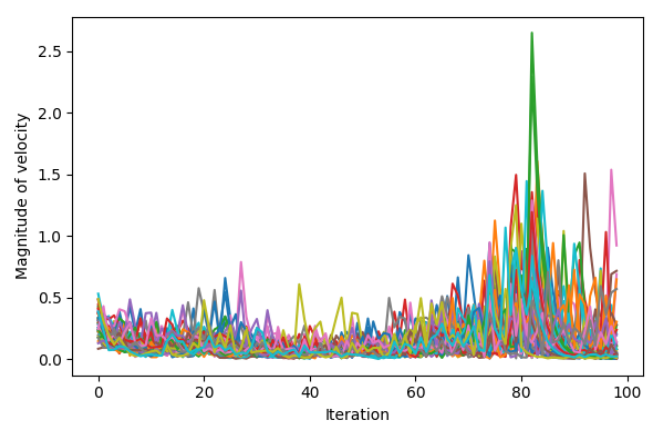
Figure 12. Velocity magnitudes for each of the particle position updates throughout the optimisation process using the BLSK-S weight inheritance method.